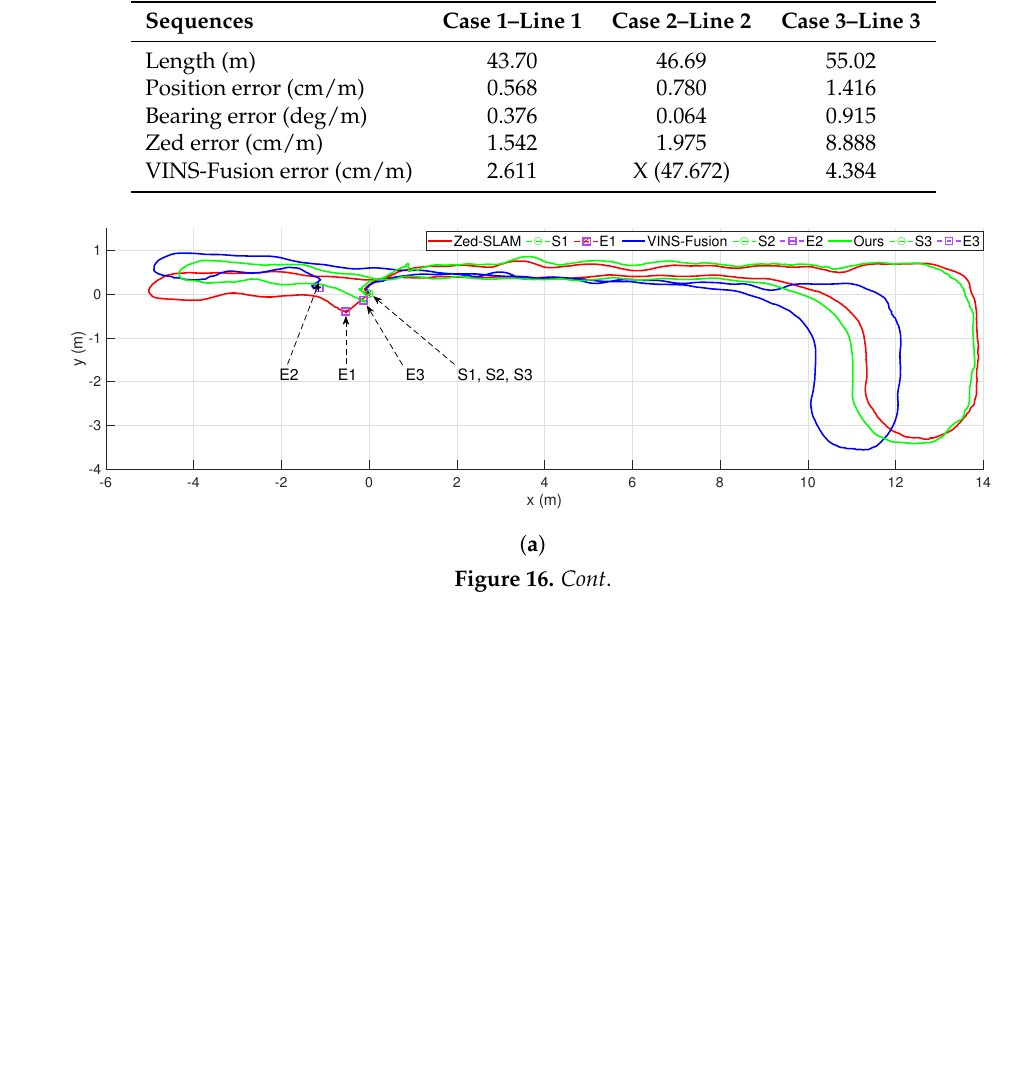
Figure 15. The estimated trajectories in a stochastic environment along the hallway outside our lab around 7 m × 25 m with various scenarios are illustrated. Line 1 is a path without the dynamic object; Line 2 is with the moving person but sparse, Line 3 is with a very dense active person; all cases are under the influence of illumination. Point S1, S2, and S3 are start poses of all paths while E1, E2, and E3 are end positions of scenario 1, 2, and 3, respectively. Table 3. The comparison of the proposed method to Zed-SLAM and VINS-Fusion.